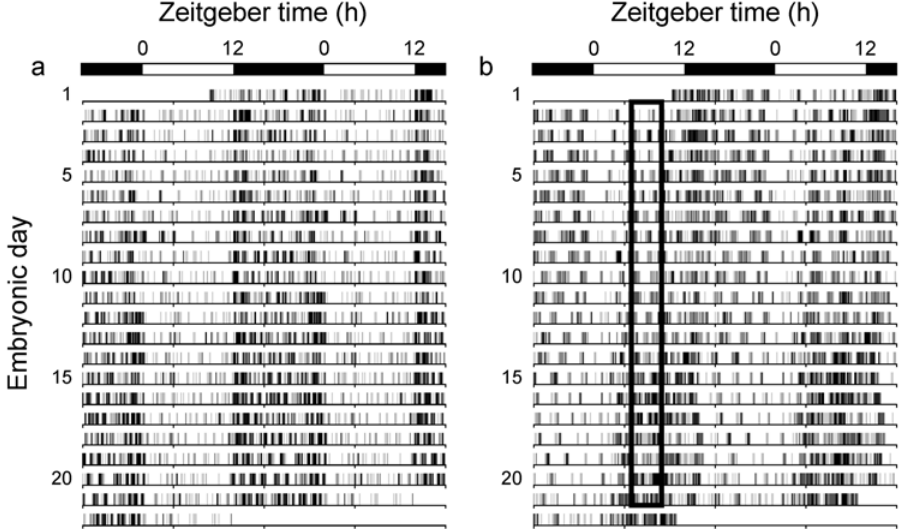
Figure 1. Representative locomotor activity records from pregnant Per1-luc transgenic rats. (a) shows activity in an animal under ad lib feeding. (b) shows activity in animals given access to food for 4 hours each day (the restricted feeding (RF) group). The open boxes in (b) indicate the daily food-access interval. The bars at the top indicate the light period in white and dark period in black. For rats in the RF group, food access was restricted to a 4-hour period at zeitgeber time (ZT) 5–9 for 21 days of pregnancy (where ZT0 is lights on and ZT12 is lights off). RF in (b) resulted in typical anticipatory activity occurring before food access. During the RF, activity is generally increased and the nighttime activity is shifted forward toward the food-access period of